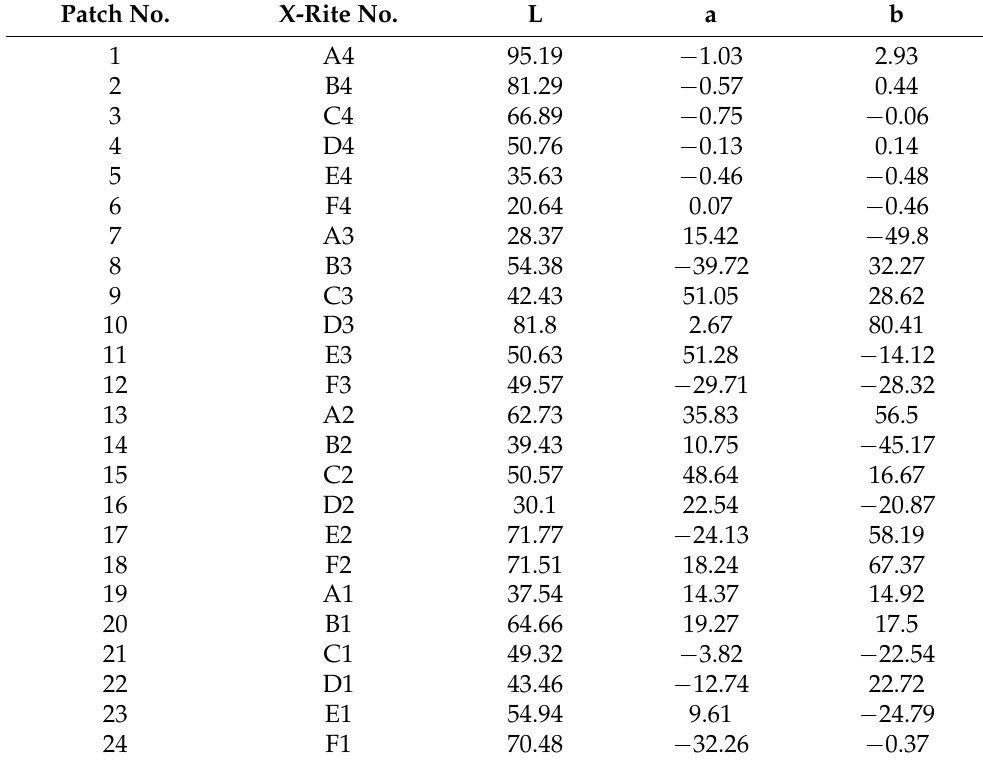
Table 2. The colorimetric reference data for the ColorChecker Classic chart provided by X-Rite. X-Rite No. is the patch name used by X-Rite; L is the luminance value; a and b are color coordinates. Patch